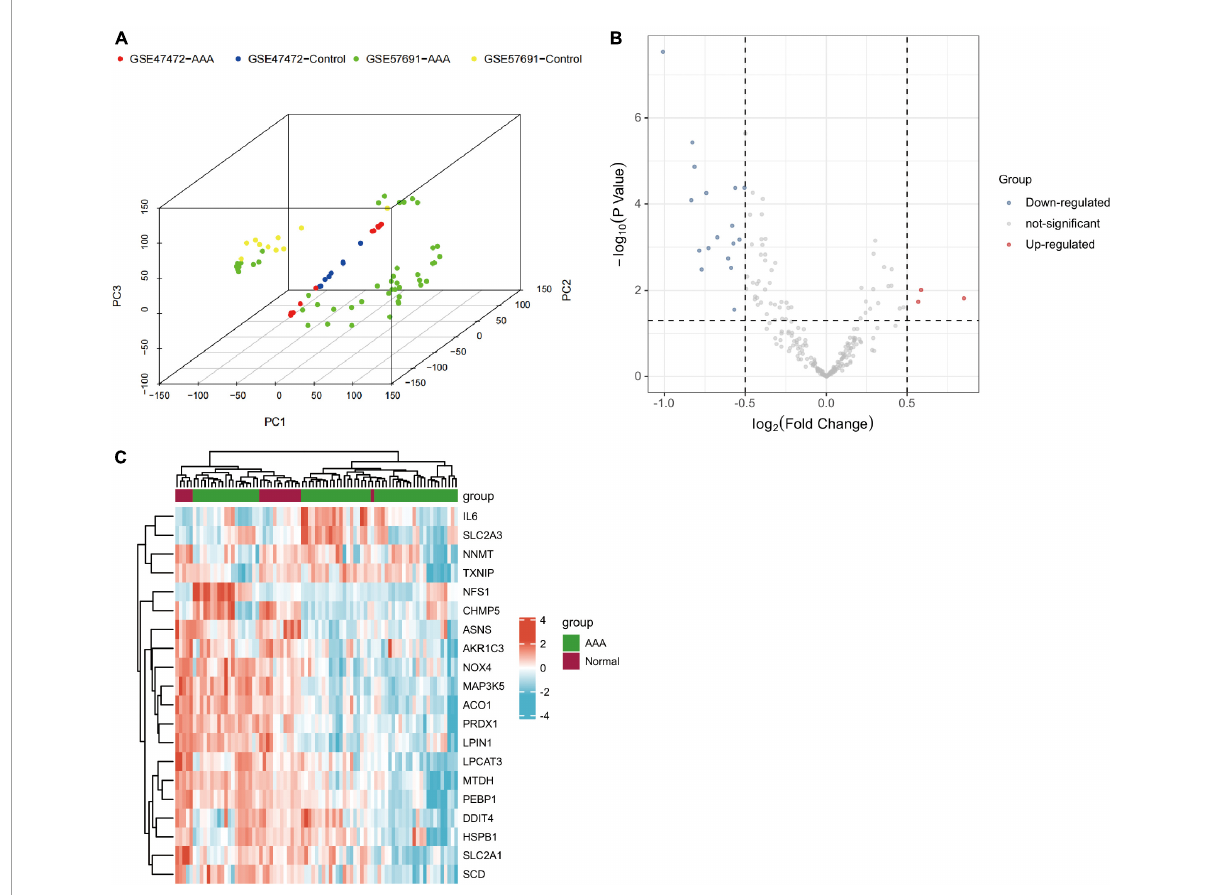
FIGURE2 Differentially expressed ferroptosis-related genes in AAA and healthy samples. (A) Results of the PCA. In the PCA picture, AAA in GSE47472 is marked in red, control in GSE47472 is marked in blue, AAA in GSE57691 is marked in green and control in 8 GSE57691 is marked in yellow. (B) Volcano plot of differentially expressed ferroptosis-related genes. Significantly upregulated and downregulated genes are represented by red and blue dots, respectively. Criteria used for the identification of differences: P<0.05 and | log FC| > 0.5. (C) Heatmap of 20 differentially expressed ferroptosis-related genes in AAA and healthy samples. AAA, abdominal aortic aneurysm; FC, fold change; PCA, principal component